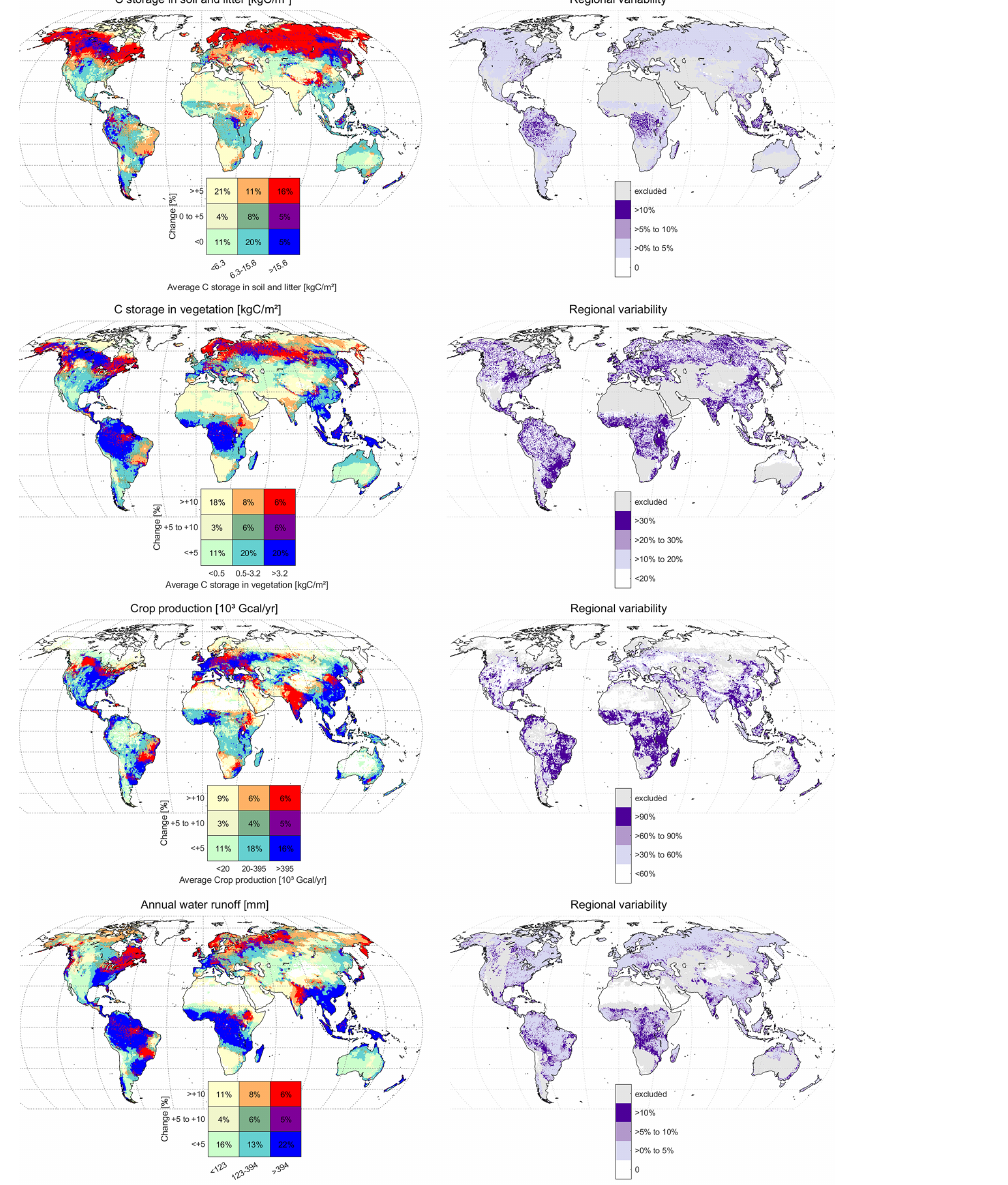
Figure 4. The left column shows the categories of the average level of the provision of selected ES indicators in 2000–2004 and the relative change until 2036–2040 averaged over 16 land-use scenarios. Thresholds for categories for the average ES indicator level follow the 33rd and 67th percentiles for each ES indicator, whereas the change in indicators is given in 5% steps for all indicators to allow for comparability. Note that for soil and litter C, the lowest category is negative. At high levels of ES indicator provision (highest 33% of values), blue cells mark regions where little change is expected on average until 2040, and red cells mark regions where high changes are expected until 2040. The yellow category marks regions where base levels in ES provision are low; therefore, relative changes in these regions can be very high but are of minor importance. The percentage of global land area in each category is indicated. Cells where the average indicator level in 2000–2004 is zero are colored white and excluded from the statistical analysis. The right column gives the variability of the percent change in each ES indicator for each cell, which was calculated as the standard deviation of the changes in the ES indicator from 2000–2004 to 2036–2040 that was derived for each of the 16 land-use scenarios individually. Regions where the base level in 2000–2004 was below the 33rd percentile (yellow to green cells in the left column) were excluded from regional variability maps and colored gray in order to focus on cells with relevant ES indicator provision. Note that the legend scaling is different for vegetation C and crop yield production. Purple regions indicate a standard deviation in the predicted relative changes in this indicator higher than 10% of the indicator level in 2000–2004 (30% for vegetation C and 90% for crop yield production). See Fig. S2 for NPP, total C storage and